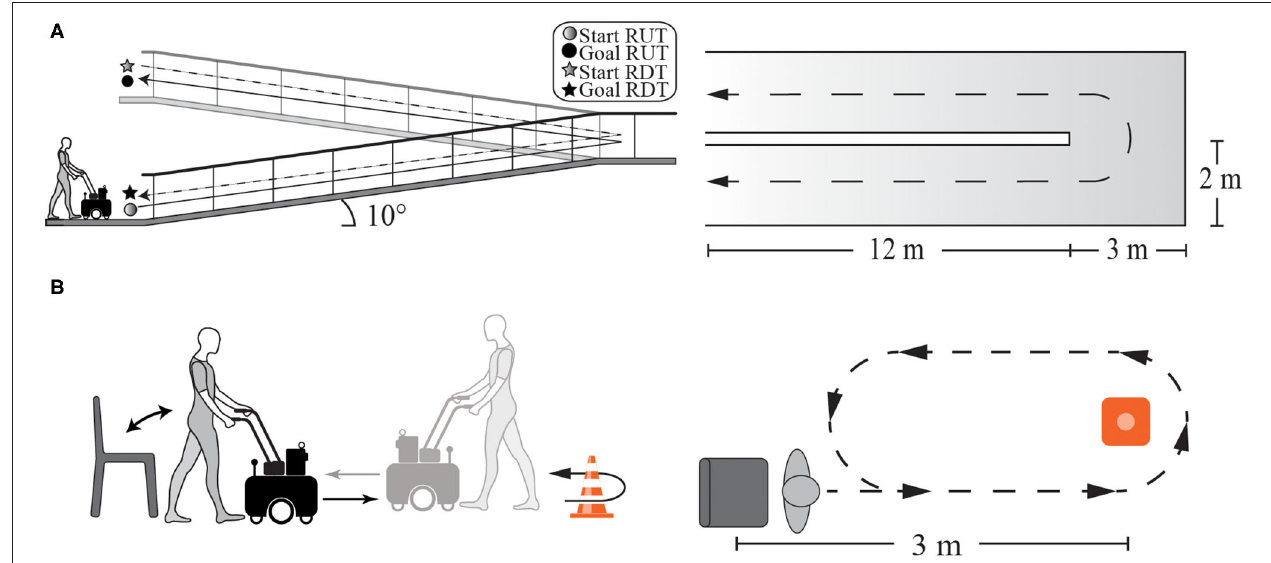
FIGURE 3 | Illustration of experimental setups of the daily living activities part. (A) Ramps test setup. (B) Timed Up and Go test (TUGT) setup.